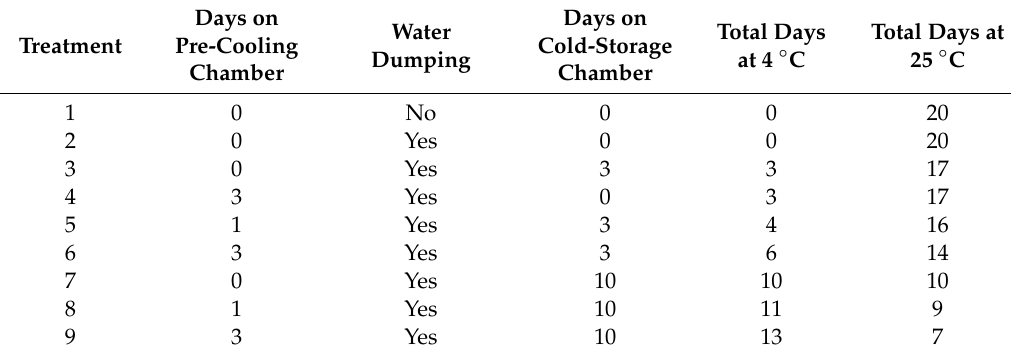
Table 1. Details of the di ff erent postharvest handling treatments. The temperature in pre-cooling and the cold storage chamber was 4 ◦ C at either 75% relative humidity (RH) or 100% RH. The temperature in water dumping was 15 ◦ C for 10